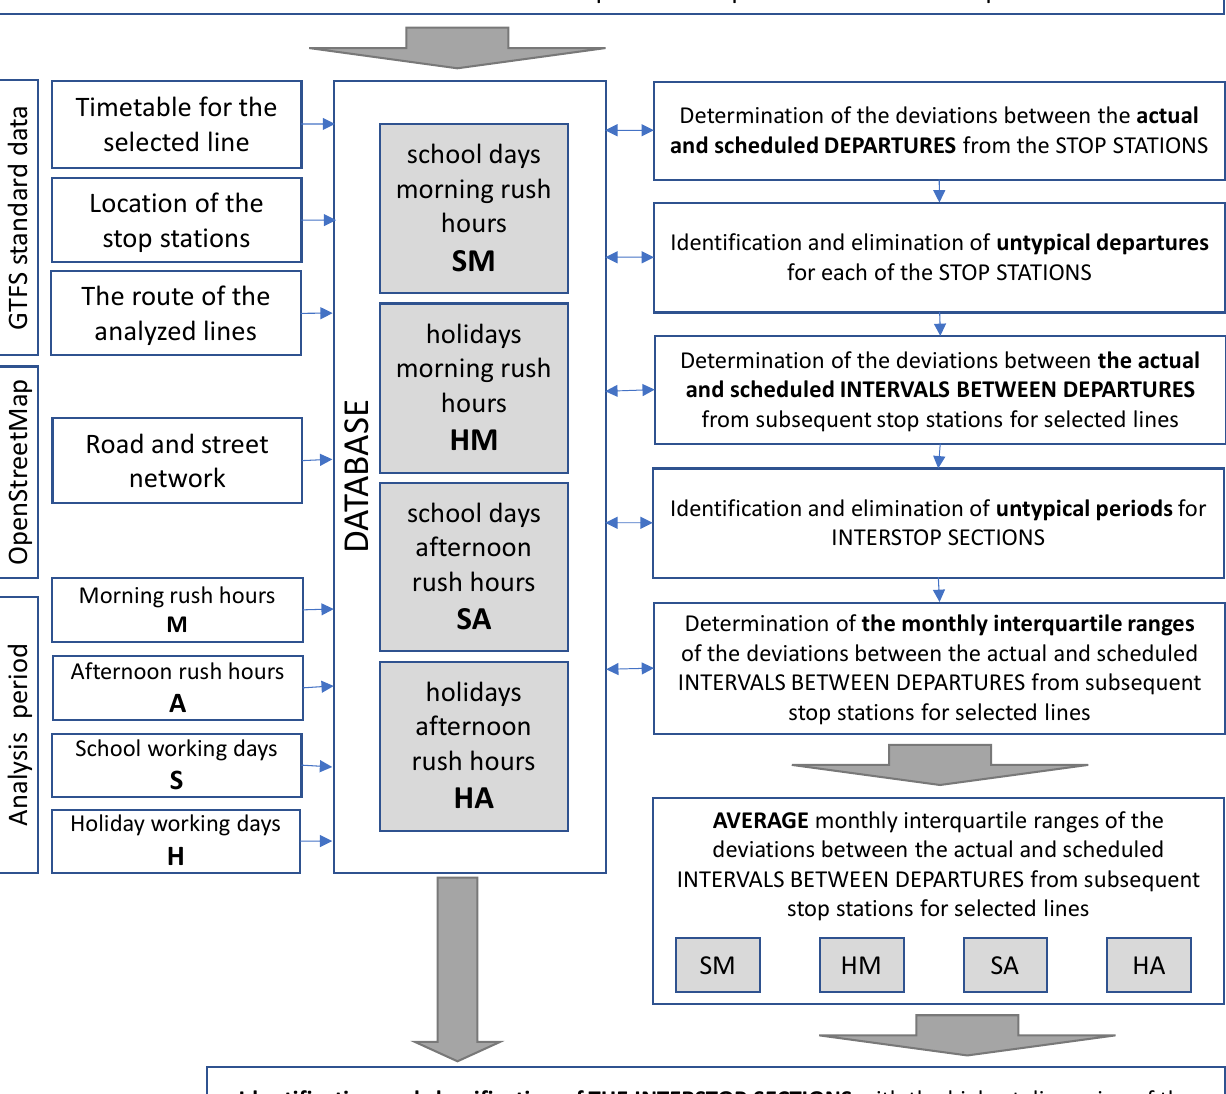
Identification and classification of THE INTERSTOP SECTIONS with the highest dispersion of the deviations between the actual and scheduled INTERVALS BETWEEN DEPARTURES from subsequent stop stations for selected lines Figure 1. The scheme of the research method. Figure 1. The scheme of the research